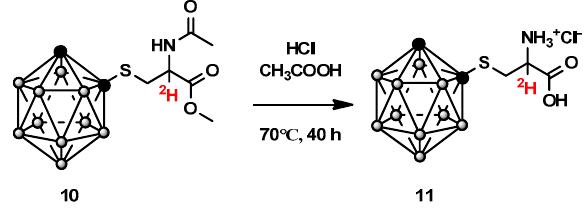
Figure 7. 1 H NMR spectrum of 11 in methanol-d 4. The method proposed above can be considered as a preparative one for the synthesis of labeled o-carboranyl-DL-[ α - 2 H]-cysteine, which could be useful for study of the metabolism of o-carboranyl-DL-cysteine itself, as well as the metabolism of boron-containing proteins on its base as potential BNCT agents [44–46]. It was mentioned that the o-carborane system is sensitive to the presence of a base. To investigate the effect of water-soluble basic salt toward the reaction that proceeds in a two-phase system, we added K 2 CO 3 to the reaction system. We found that the addition of a basic salt accelerates the reaction, which is complete in 8 hours, but resulted in an only 17% yield of 8 , while the main product is nido -carborane derivatives, as found by 11 B NMR. The solvent change from H 2 O to 2 H 2 O along with the use of anhydrous K 2 CO 3 and a Schlenk technique under an atmosphere of argon increases the reaction time from 8h to 10h due to the isotope effect, and the yield of product falls from 17% to 10%. Interestingly, the structure of the resulting product was found to be different from 8 and 10 . According to the NMR spectroscopy data, deuterium from 2 H 2 O took up a place of the 1-CH- o- carborane proton, whereas proton appeared at the α -position of the amino acid (Scheme 4, Figure 8). Compound 12 was isolated and characterized, and its structure and composition were confirmed by 1 H, 11 B, 13 C NMR, and IR spectroscopy and high-resolution mass